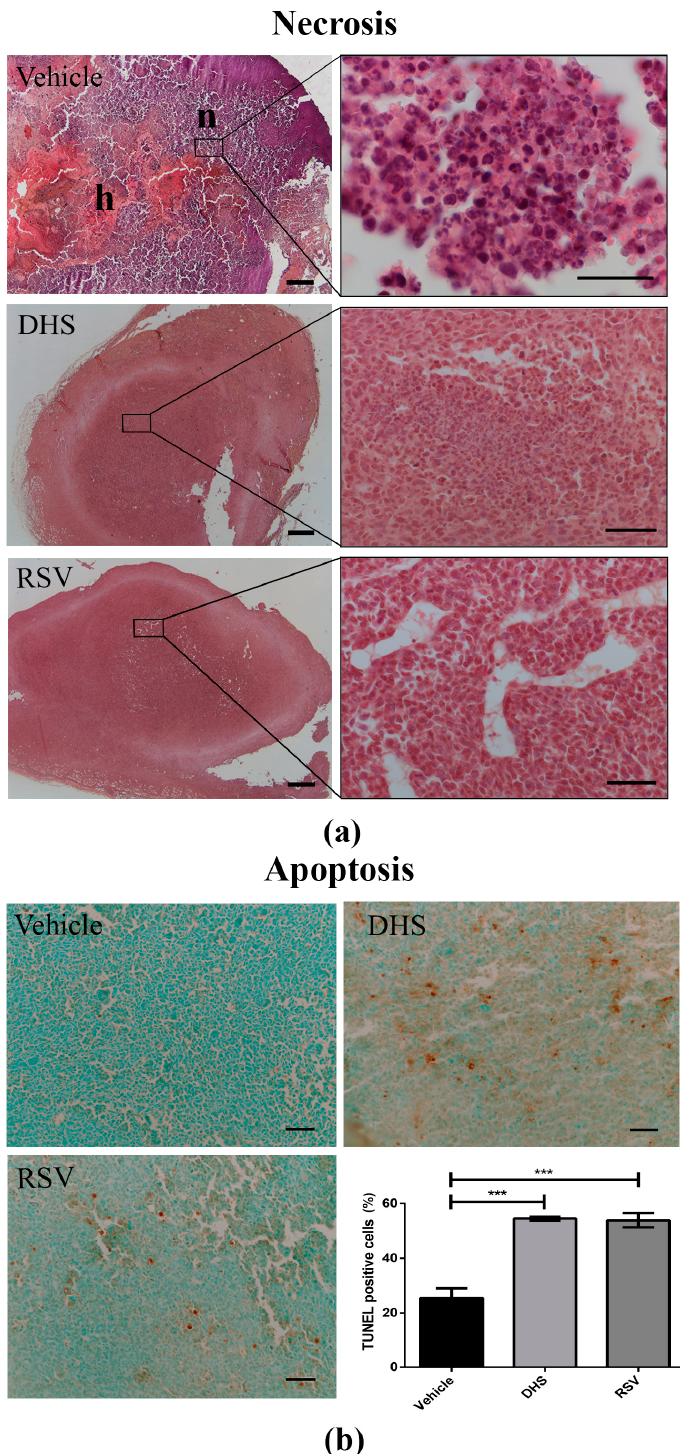
Figure 5. ( a ) Representative photomicrographs of H&E staining for vehicle, DHS, and RSV tumour masses (scale bars = 1000 μ m; 4× magnification (left) and 100× magnification (right), n = necrosis, h = haemorrhage); ( b ) Representative photomicrographs of immunohistochemical staining for apoptotic cells in vehicle, DHS, and RSV tumour masses (scale bars = 100 μ m; 100× magnification), and relative quantitative analysis (*** p < 0.001).